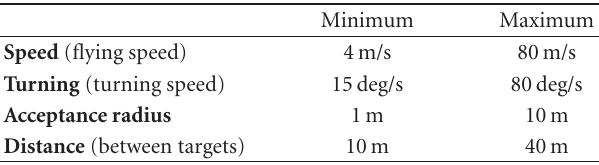
Table 1: Exploratory parameter space used in the NTT pilot-testing